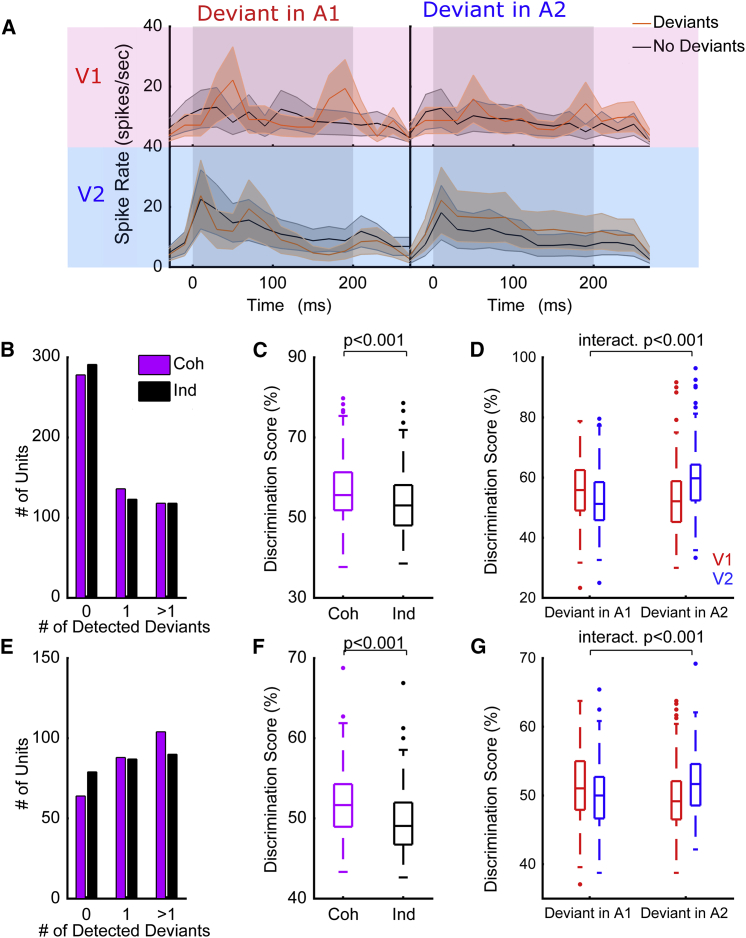
Temporally Coherent Changes in Visual Luminance and Auditory Intensity Enhance the Representation of Auditory Timbre(A) Example unit response (from the awake dataset) showing the influence of visual temporal coherence on spiking responses to dual-stream stimuli with (red PSTH) or without (black PSTH) timbre deviants.(B and C) Timbre deviant discrimination in the awake dataset. Two deviants were included in each auditory stream giving a possible maximum of 4 per unit (B), histogram showing the number of deviants (out of 4) that could be discriminated from spiking responses (C), and boxplots showing the timbre deviant discrimination scores in the single-stream condition across different visual conditions (Coh: coherent, ind: independent). The boxes show the upper- and lower-quartile values, the horizontal lines indicate the median, and the whiskers depict the most extreme data points not considered to be outliers (which are marked as individual symbols).(D) Discrimination scores for timbre deviant detection in dual-stream stimuli in awake animals. Discrimination scores are plotted according to the auditory stream in which the deviant occurred and the visual stream that accompanied the sound mixture. V1 stimuli are plotted in red, and V2 stimuli in blue; therefore, the boxplots at the far left and right of the plot represent the cases in which the deviants occurred in an auditory stream that was temporally coherent with the visual stimulus, while the central two boxplots represent the discrimination of deviants occurring in the auditory stream that was temporally independent of the visual stimulus.(E–G) The same as (B)–(D) but for the anesthetized dataset.See also Figure S6.